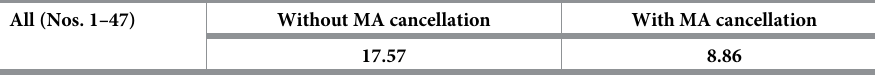
Table 2. Comparison summary of the HR estimation results obtained with and without MA cancellation. Each result was obtained from all datasets ( n = 47): ISPC ( n = 23) and BAMI ( n = 24) datasets. The performance was evalu- ated on the basis of the mean absolute error